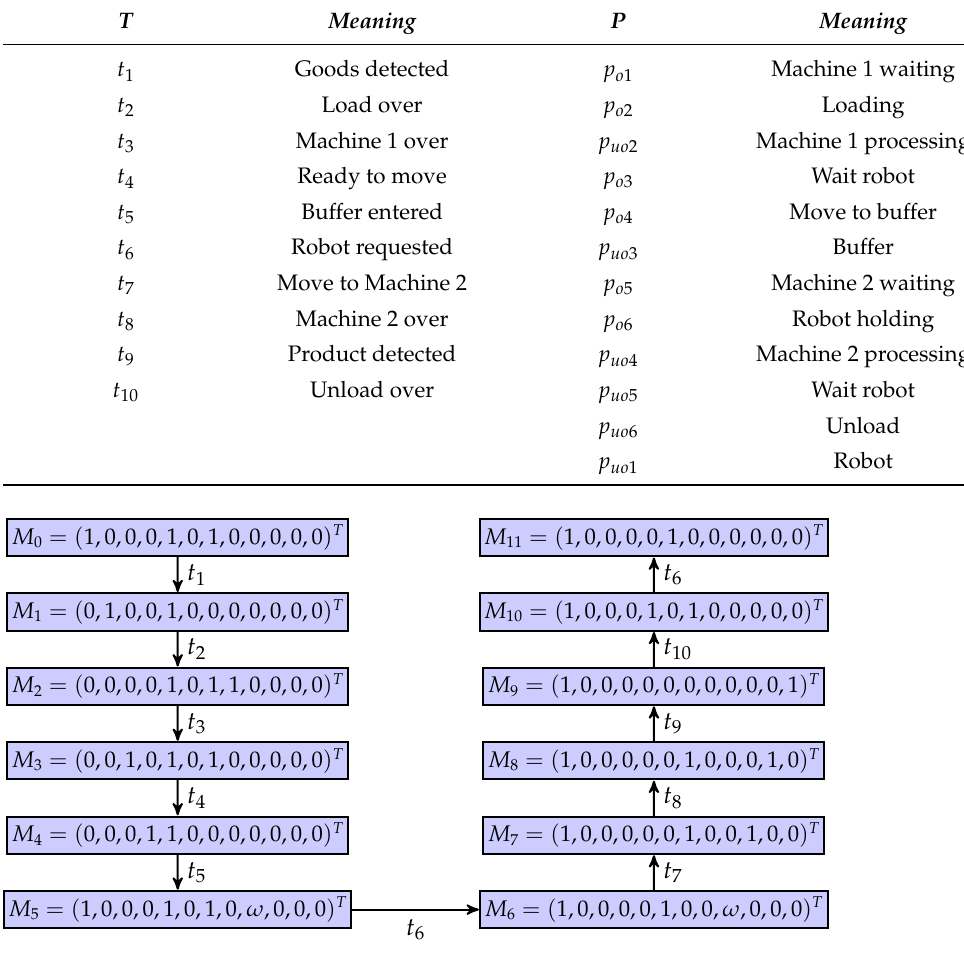
Table 3. Meaning of transitions and places.